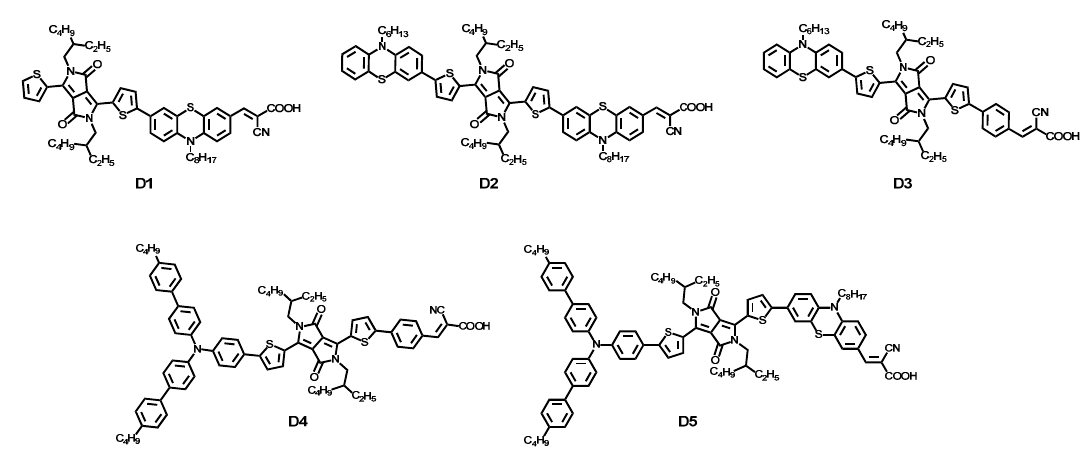
Figure 1. Chemical structures of the target dyes D1 ‒ D5 .